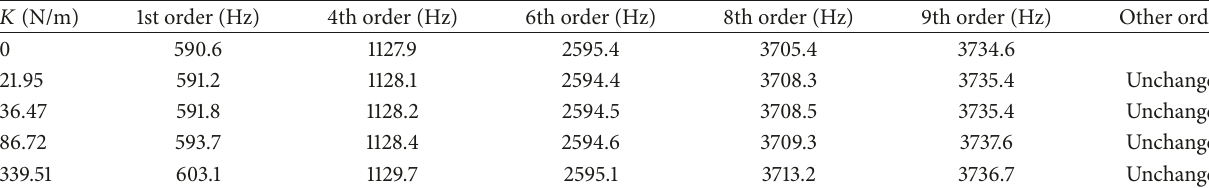
Table 2: The results of modal analysis of armature assembly with and without